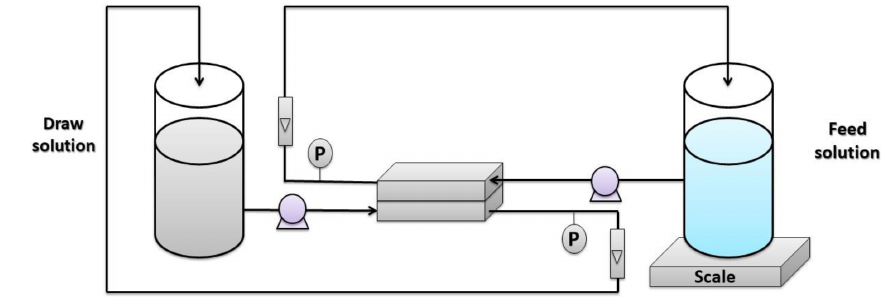
Figure 2. Schematic diagram of the FO bench-scale test